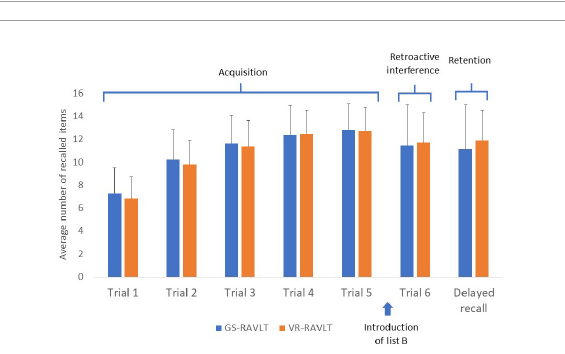
FIGURE3 Average number of remembered items in each trial for both test formats. It can be appreciated that the Acquisition, Retroactive Interfere and the Retention patterns are similar.